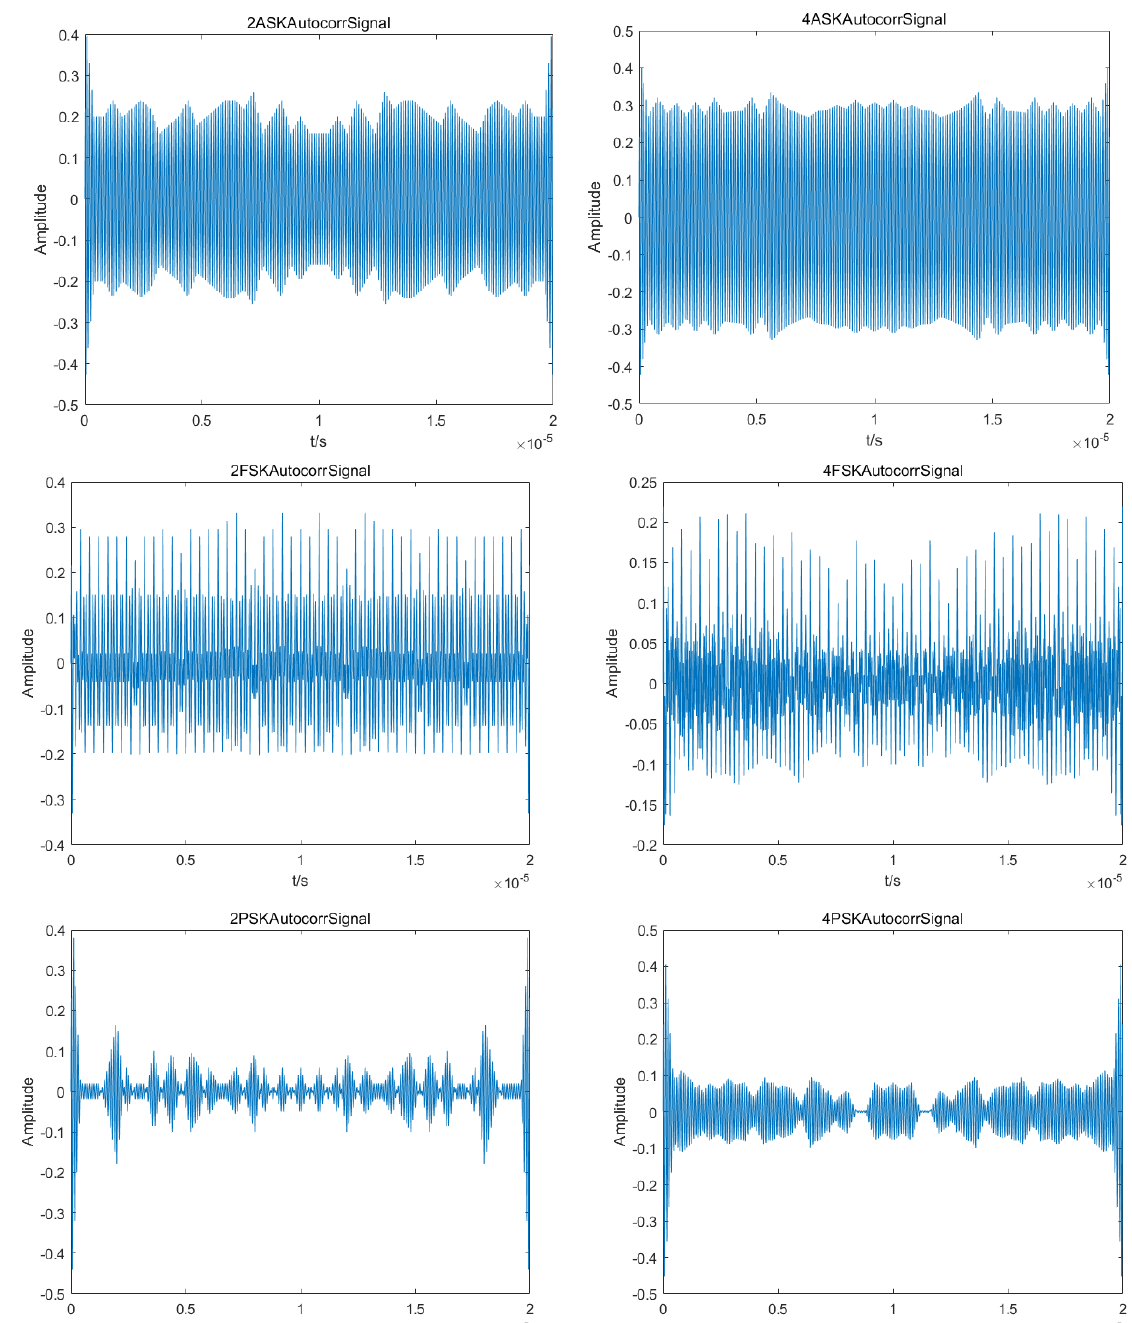
Figure 7. Autocorrelation function of each modulation signal.